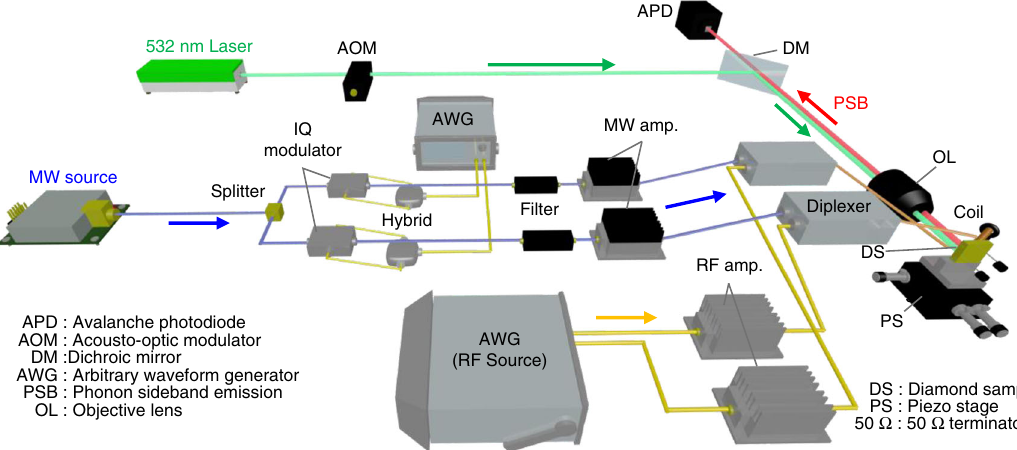
Fig. 6 Energy-level diagram for the geometric electron and nuclear spin and the corresponding quantum circuits. The hyper fi ne interaction ( S z S z Ising type) induces level splitting in the |±1, ±1 〉 e,N subspace. The even-parity states | + 1, + 1 〉 e,N and | − 1, − 1 〉 e,N form the Bell states Φ ± j i + 1, − 1 〉 − 1, + 1 〉 Ψ ± j i . Note that the sign of the nuclear quadrupole splitting Q of 14 N is different from that of the zero- fi eld e,N and | e,N form the Bell states e ; N splitting D 0 of an electron spin ( D 0 > 0 and Q < 0)